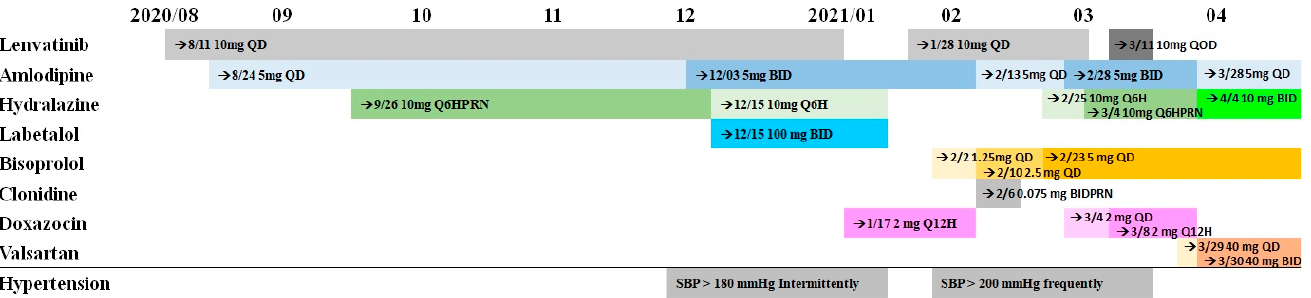
Figure 1. Timeline of the lenvatininb and anti-hypertensive agents use.